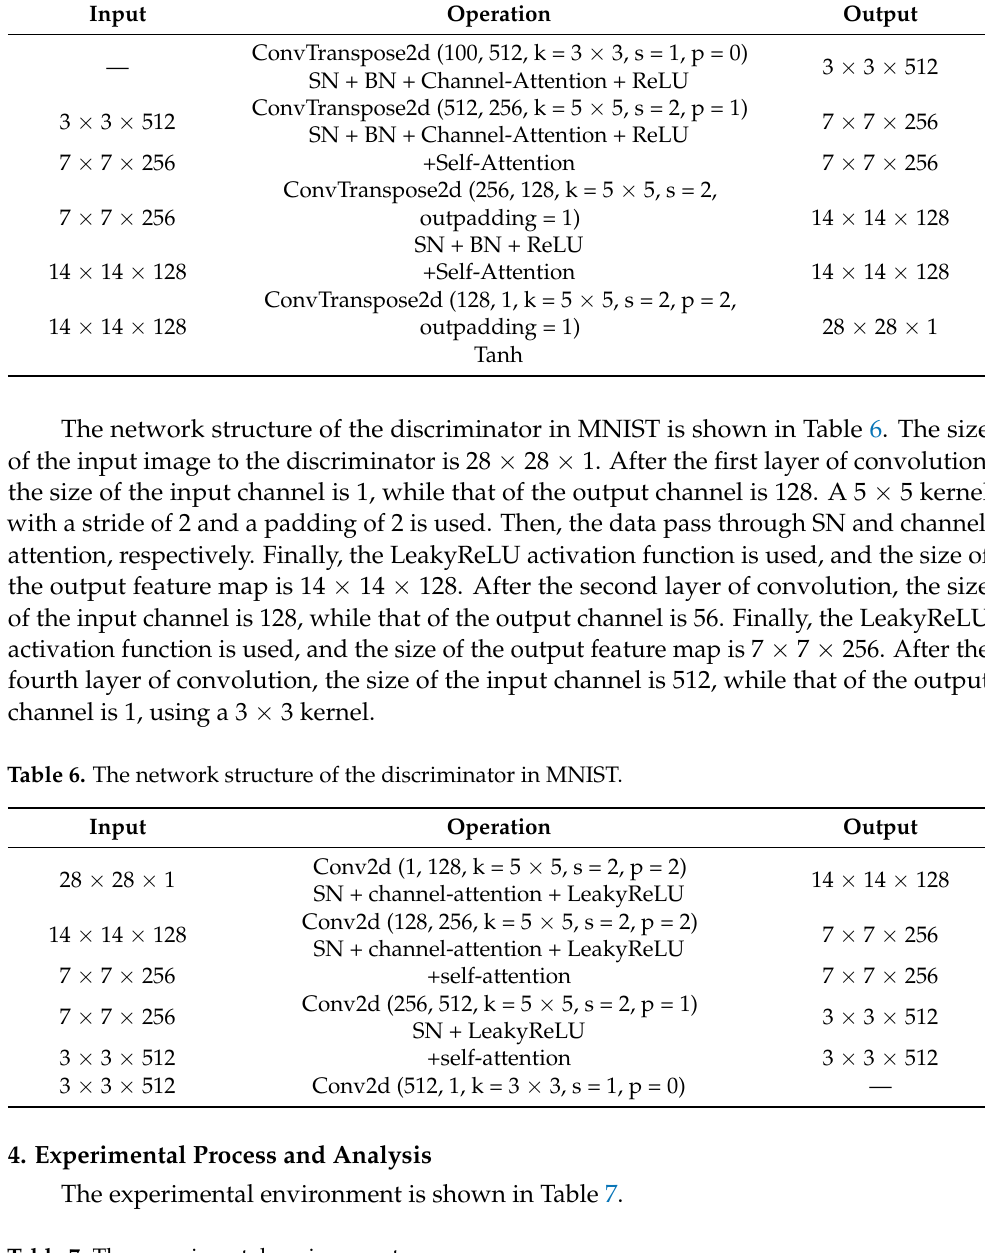
Table 7. The experimental